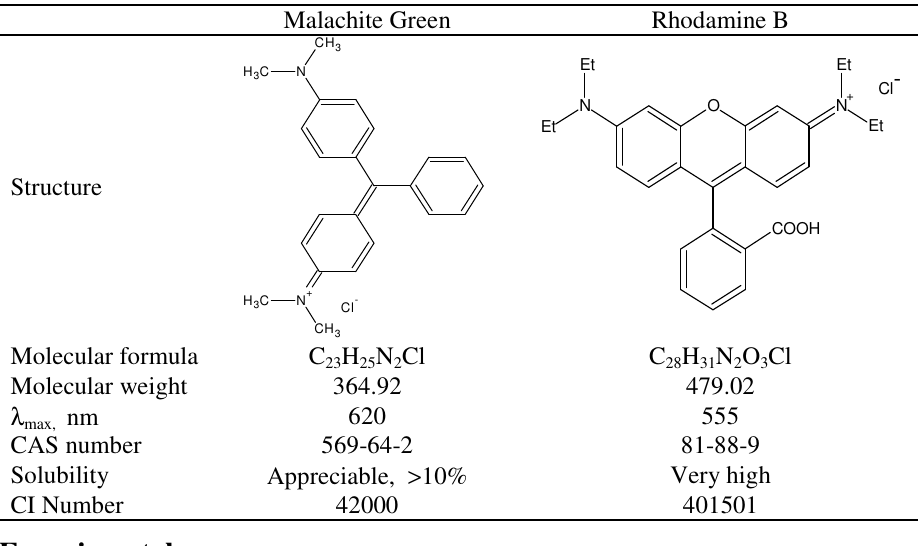
Table 1. Properties of malachite green and rhodamine